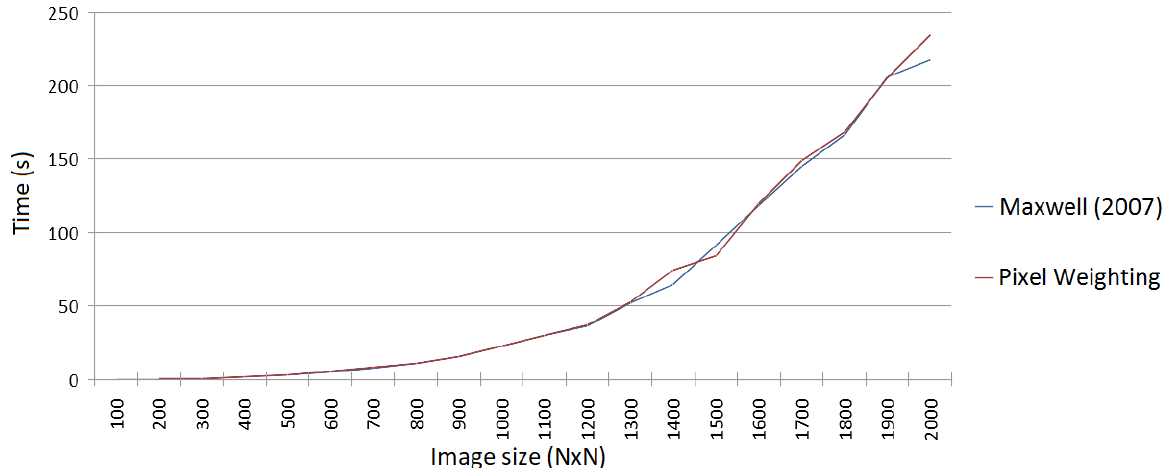
Figure 4: Execution time of Maxwell et al. (2007) gap-filling algorithm (blue) and the proposed method (red) using images ranging from 100x100 to 2000x2000